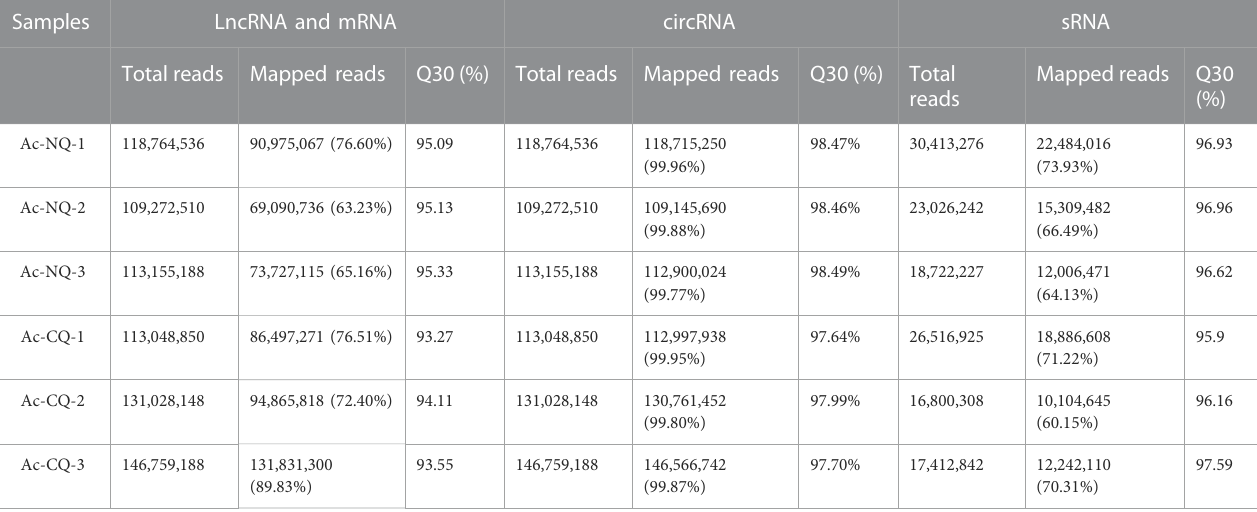
TABLE 1 The statistics of coding and non-coding RNAs.